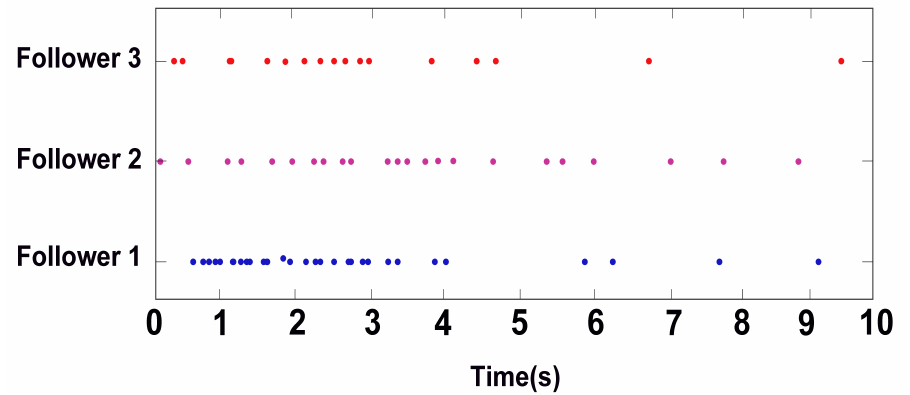
Figure 8. The triggered instants of all followers in Example